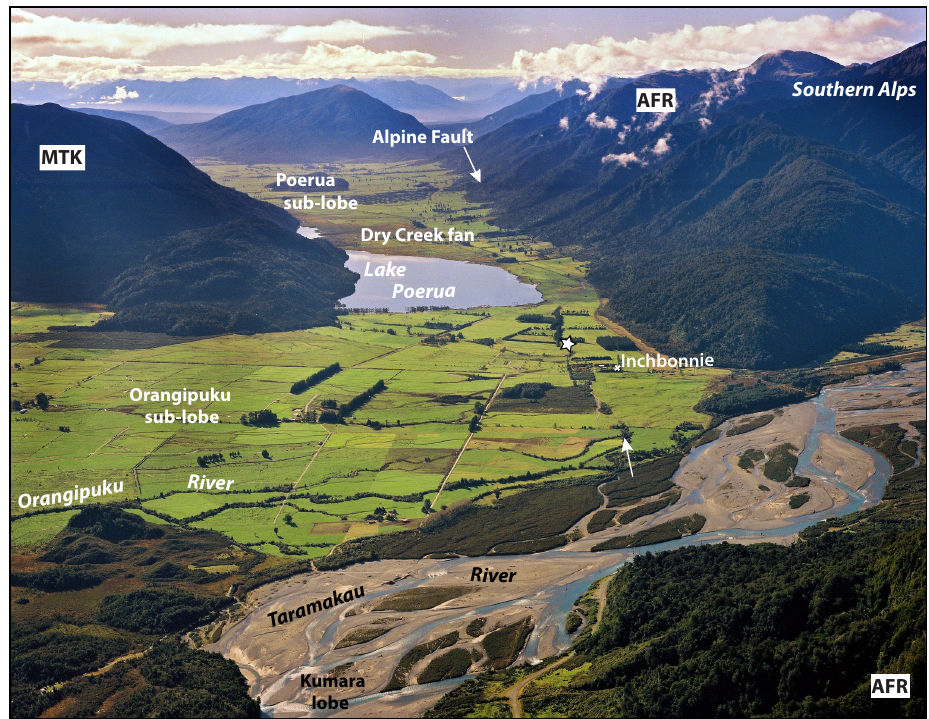
Fig. 3. Oblique aerial photograph of the Inchbonnie area viewed to the northeast toward Lake Poerua and the Alpine Fault (indicated by white arrows). The fault is characterised by a series of stepping fault traces from the river to Lake Poerua, across abandoned terraces of the Taramakau River. Abbreviations are: AFR, Alpine Fault rangefront along the edge of the Southern Alps; MTK, Mt. Te Kinga granitic massif. The Inchbonnie paleoseismic trench site is marked by a star (Photo: Lloyd Homer, GNS